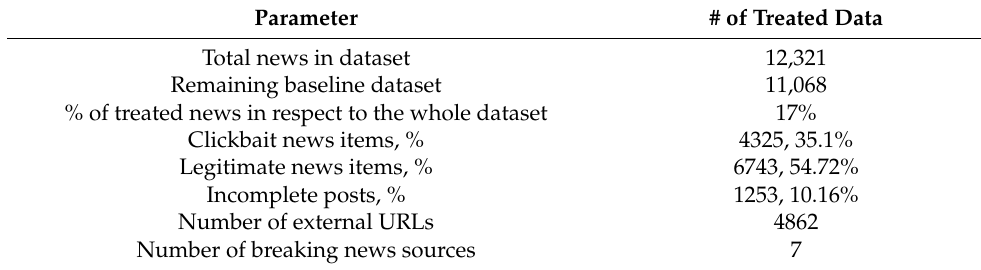
Table 5. Details of baseline